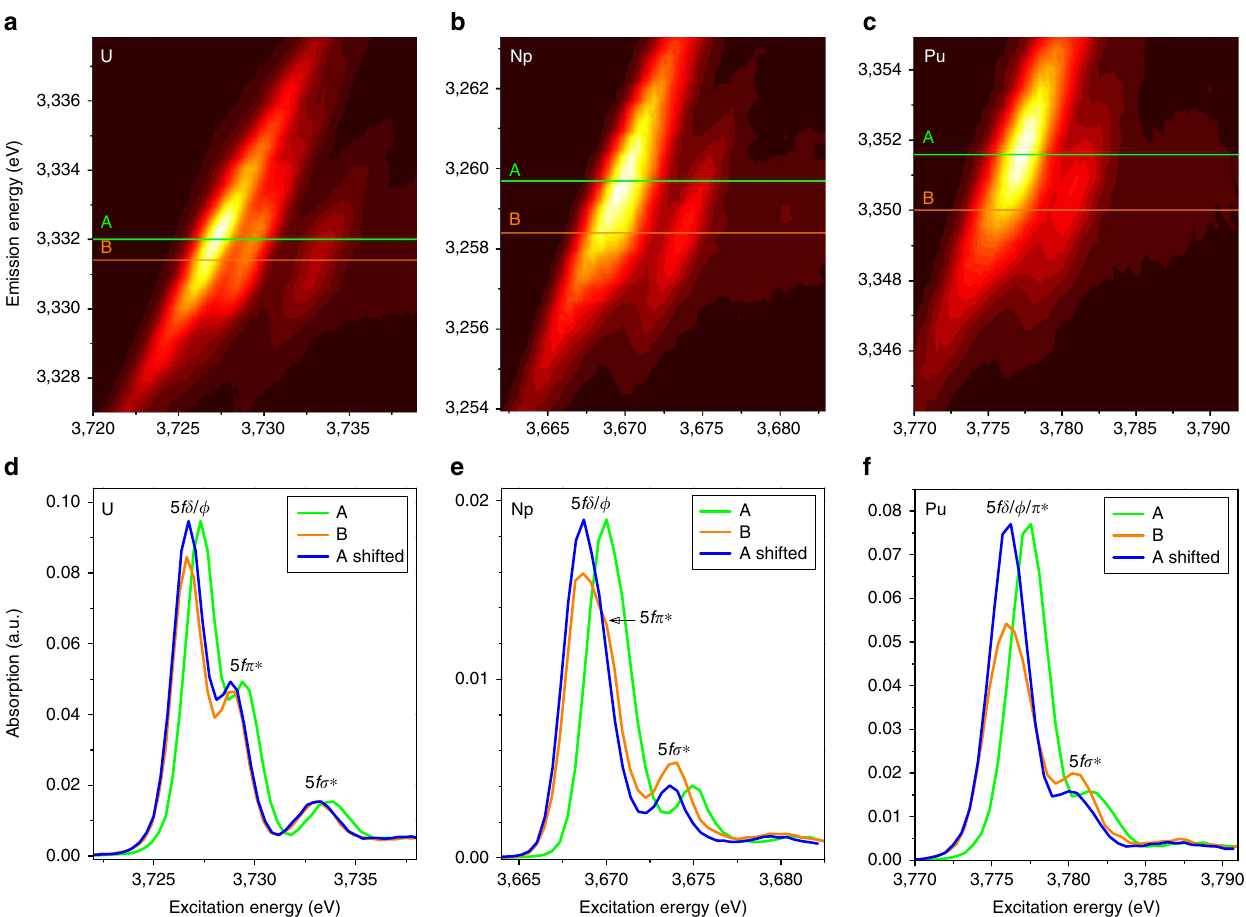
Figure 3 | RIXS maps and extracted HR-XANES spectra. ( a–c ) 3 d 4 f RIXS maps (3 d 3/2 - 5 f U M 4 absorption edge, 4 f 5/2 - 3 d 3/2 U M b emission; 3 d 5/2 - 5 f Np/Pu M 5 absorption edge, 4 f 7/2 - 3 d 5/2 Np/Pu M a emission) and ( d , e ) U M 4 and Np/Pu M 5 absorption edge HR-XANES spectra extracted along lines A and B for ( d ) UO 2 2 þ , ( e ) NpO 2 2 þ and ( f ) PuO 2 2 þ .